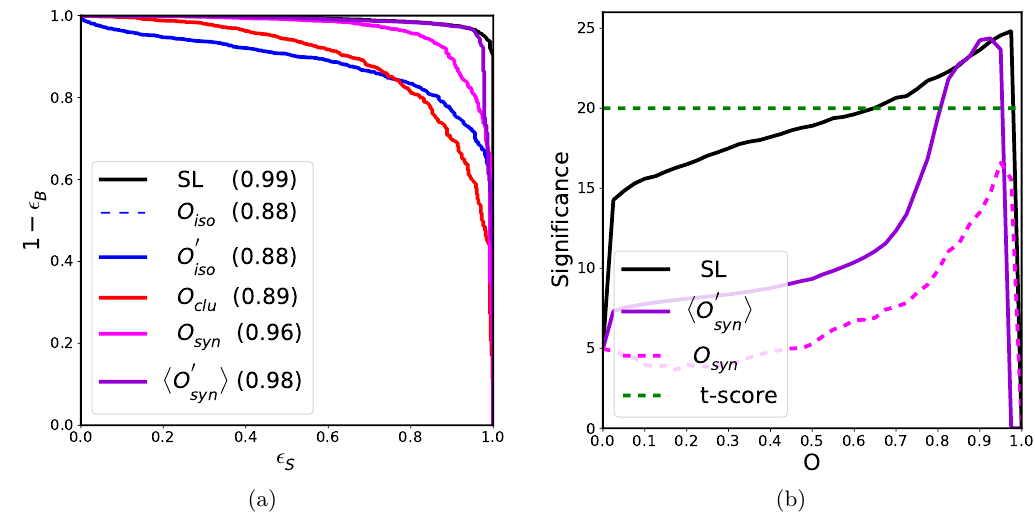
Figure 12 . (a) ROC curves and their AUC values (given in brackets) the different novelty evaluators considered and (b) statistical significance as a function of the novelty score threshold (40 bins are defined), for the specific 2D Gaussian case studied in refs. [1, 2]. Here r = 0 . 7 is taken to define the 0 signal-like sample S 0 for training O 0 . As a reference, the significance obtained in [2] is shown in syn the right panel while the SL performance is reported in